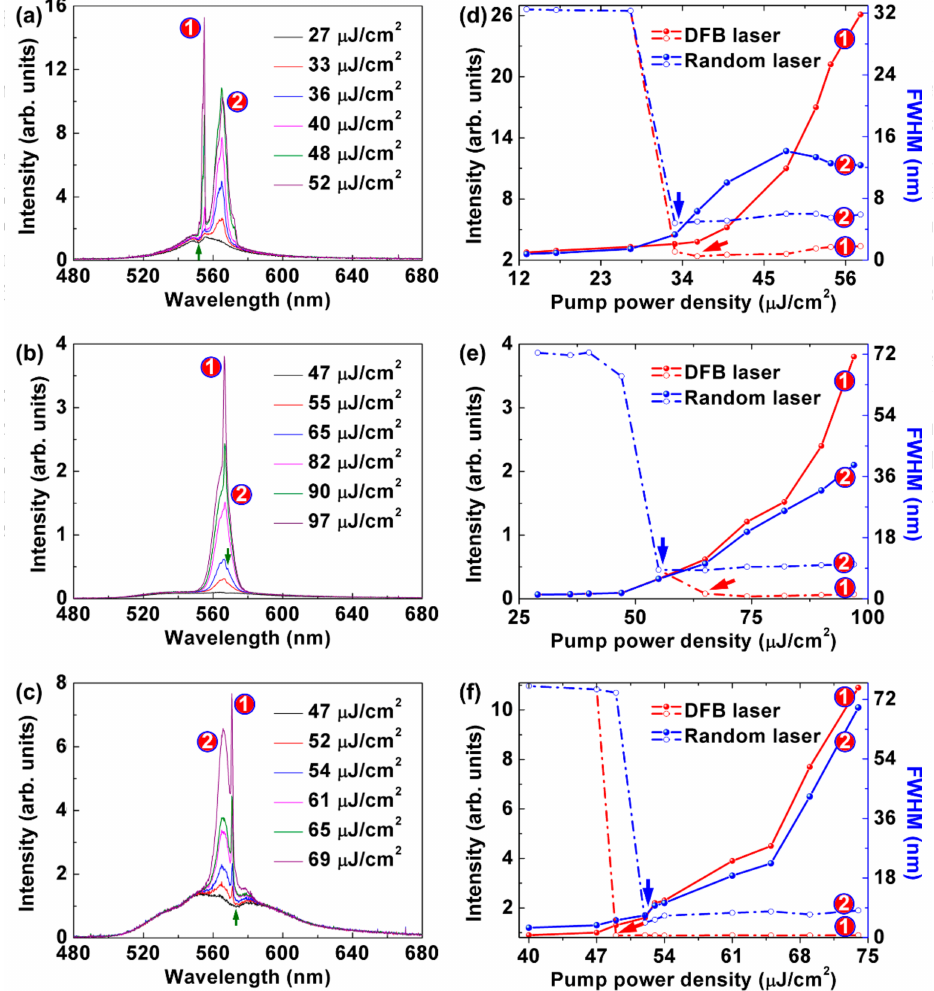
Figure 3. Emission spectra of the compound polymer lasers measured at different pump fluences. The periods of the gratings are ( a ) 350 nm, ( b ) 360 nm, and ( c ) 370 nm, respectively. FWHM and output intensity of the compound polymer lasers with ( d ) 350 nm, ( e ) 360 nm, and ( f ) 370 nm grating structures as a function of the pump fluence. The thresholds of the DFB lasing and random lasing are indicated by the red and the blue arrows,